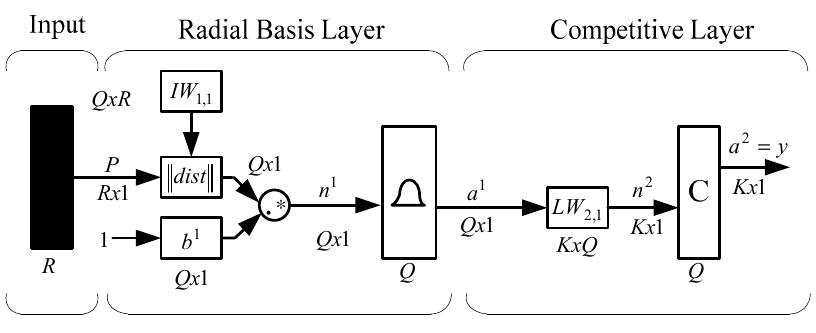
Figure 1. Probabilistic neural network [58].